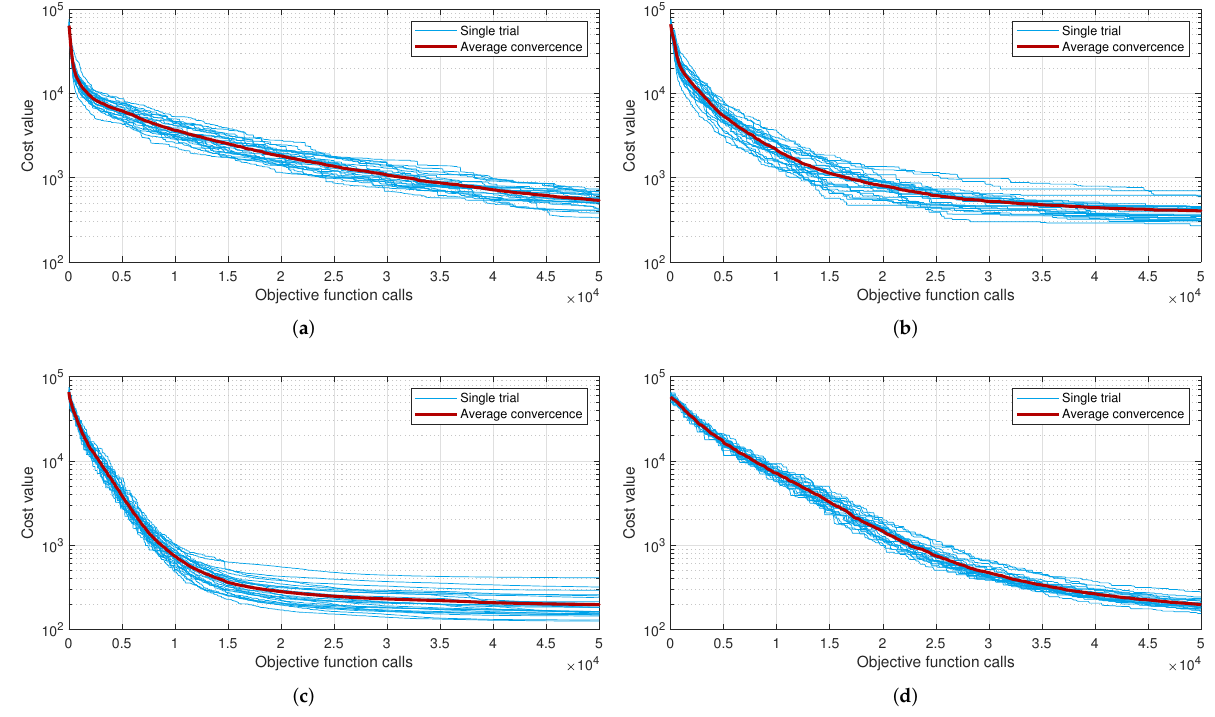
Figure 8. Convergence curves of mBBO, nBBO, DE, and SNO: each thin line corresponds to a single optimization trial, while the thick red line is the average one. ( a ) mBBO; ( b ) nBBO; ( c ) DE; ( d )